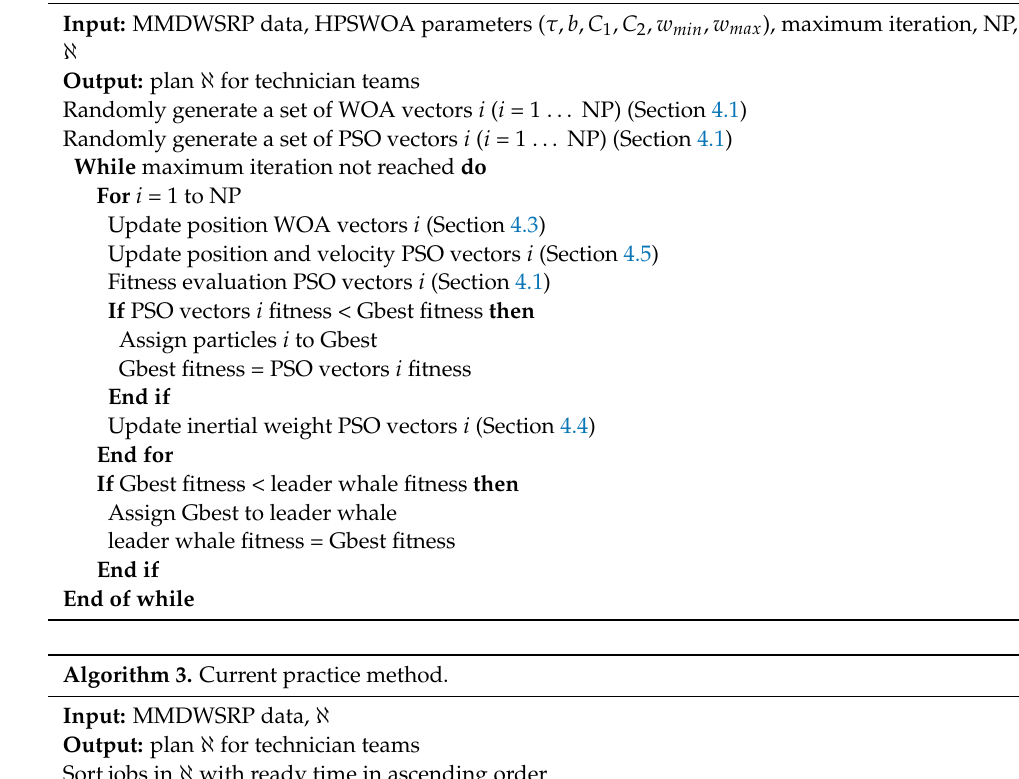
Algorithm 2. Hybrid particle swarm and whale optimization algorithm (HPSWOA).